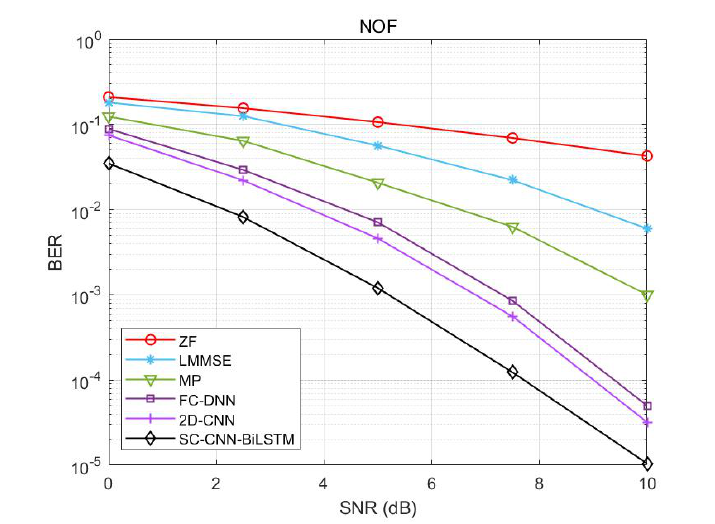
Figure 9. BER performance comparison for NOF experiment.